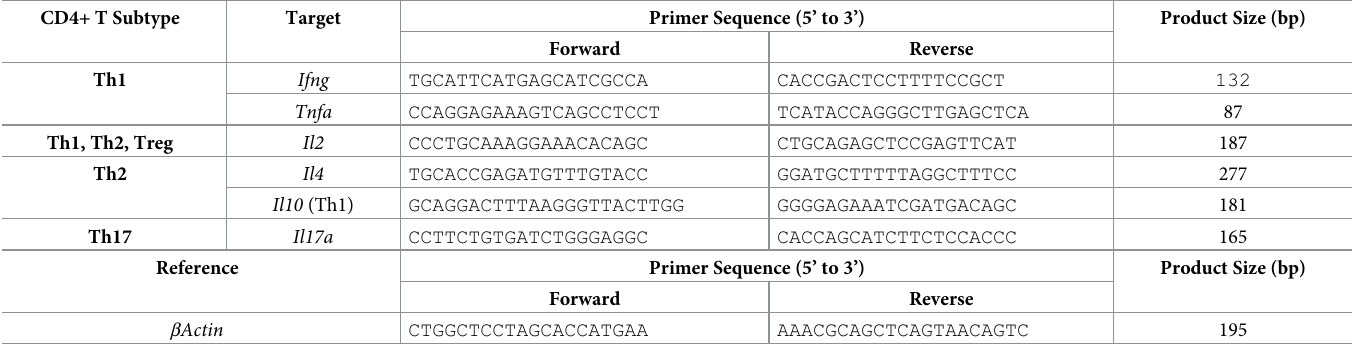
Table 2. Rat-specific primers used to detect and quantify markers associated with different CD4+ lymphocyte subtypes at the mRNA level by qPCR, with reference primers listed below. CD4+ T